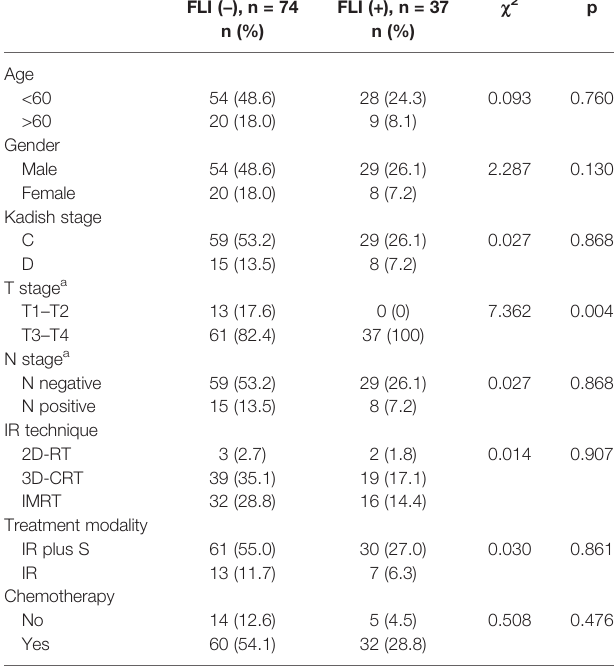
TABLE 1 | Patients ’ clinical characteristics, n =